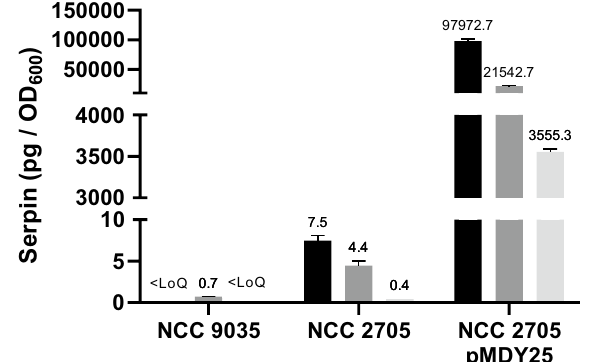
Figure 2. Serpin concentration and localization in extracts of B. longum NCC 2705, its serpin knock-out counterpart (NCC 9035) and the constitutively producing (NCC 2705 harboring pMDY25) recombinant strain. Means and standard deviations are depicted. Black bars represent cytoplasmic fractions, dark grey bars represent cell-wall associated fractions and light grey represent supernatant fractions (i.e. excreted protein). Serpin amounts are reported in picograms (pg) per mg of total